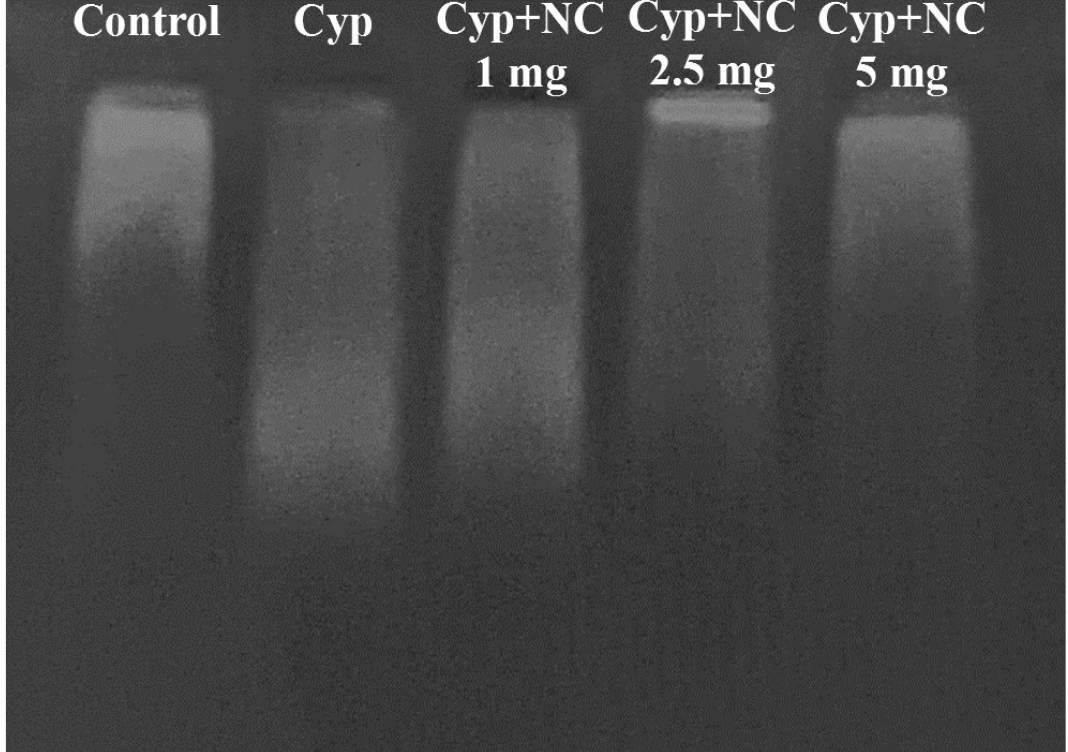
Figure 7. Cur-NLC protects genomic DNA fragmentation in the liver. Lanes are as follows: lane 1: control; lane 2: Cyp; lane 3 Cyp + Cur-NLC (1 mg); lane 4: Cyp + Cur-NLC (2.5 mg) lane 5: Cyp + Cur-NLC (5 mg). Cyp = cypermethrin; NC = NLC.